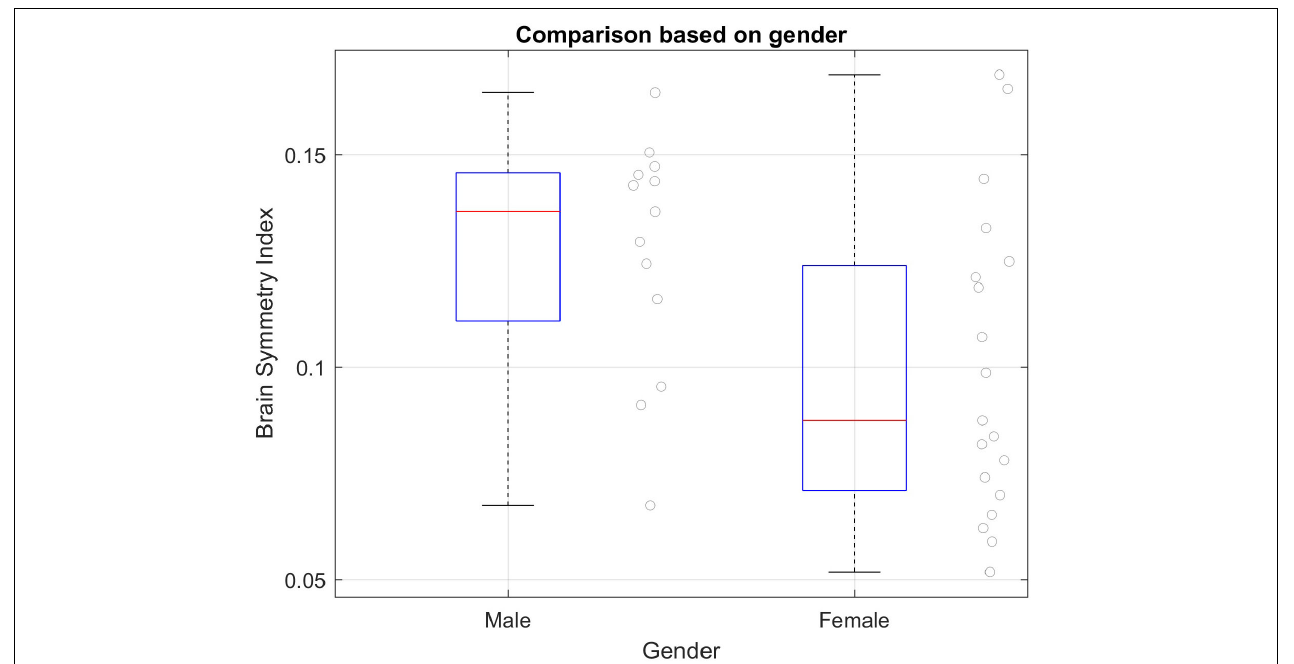
FIGURE 4 | BSI subgroup analyses based on gender in the healthy group. Mean and SD of each group: Male = 0.1272 ( SD = 0.0278); Female = 0.0997 ( SD = 0.0357). Significant difference between groups using unpaired t -test; t -value = | 2.333| P = 0.027.